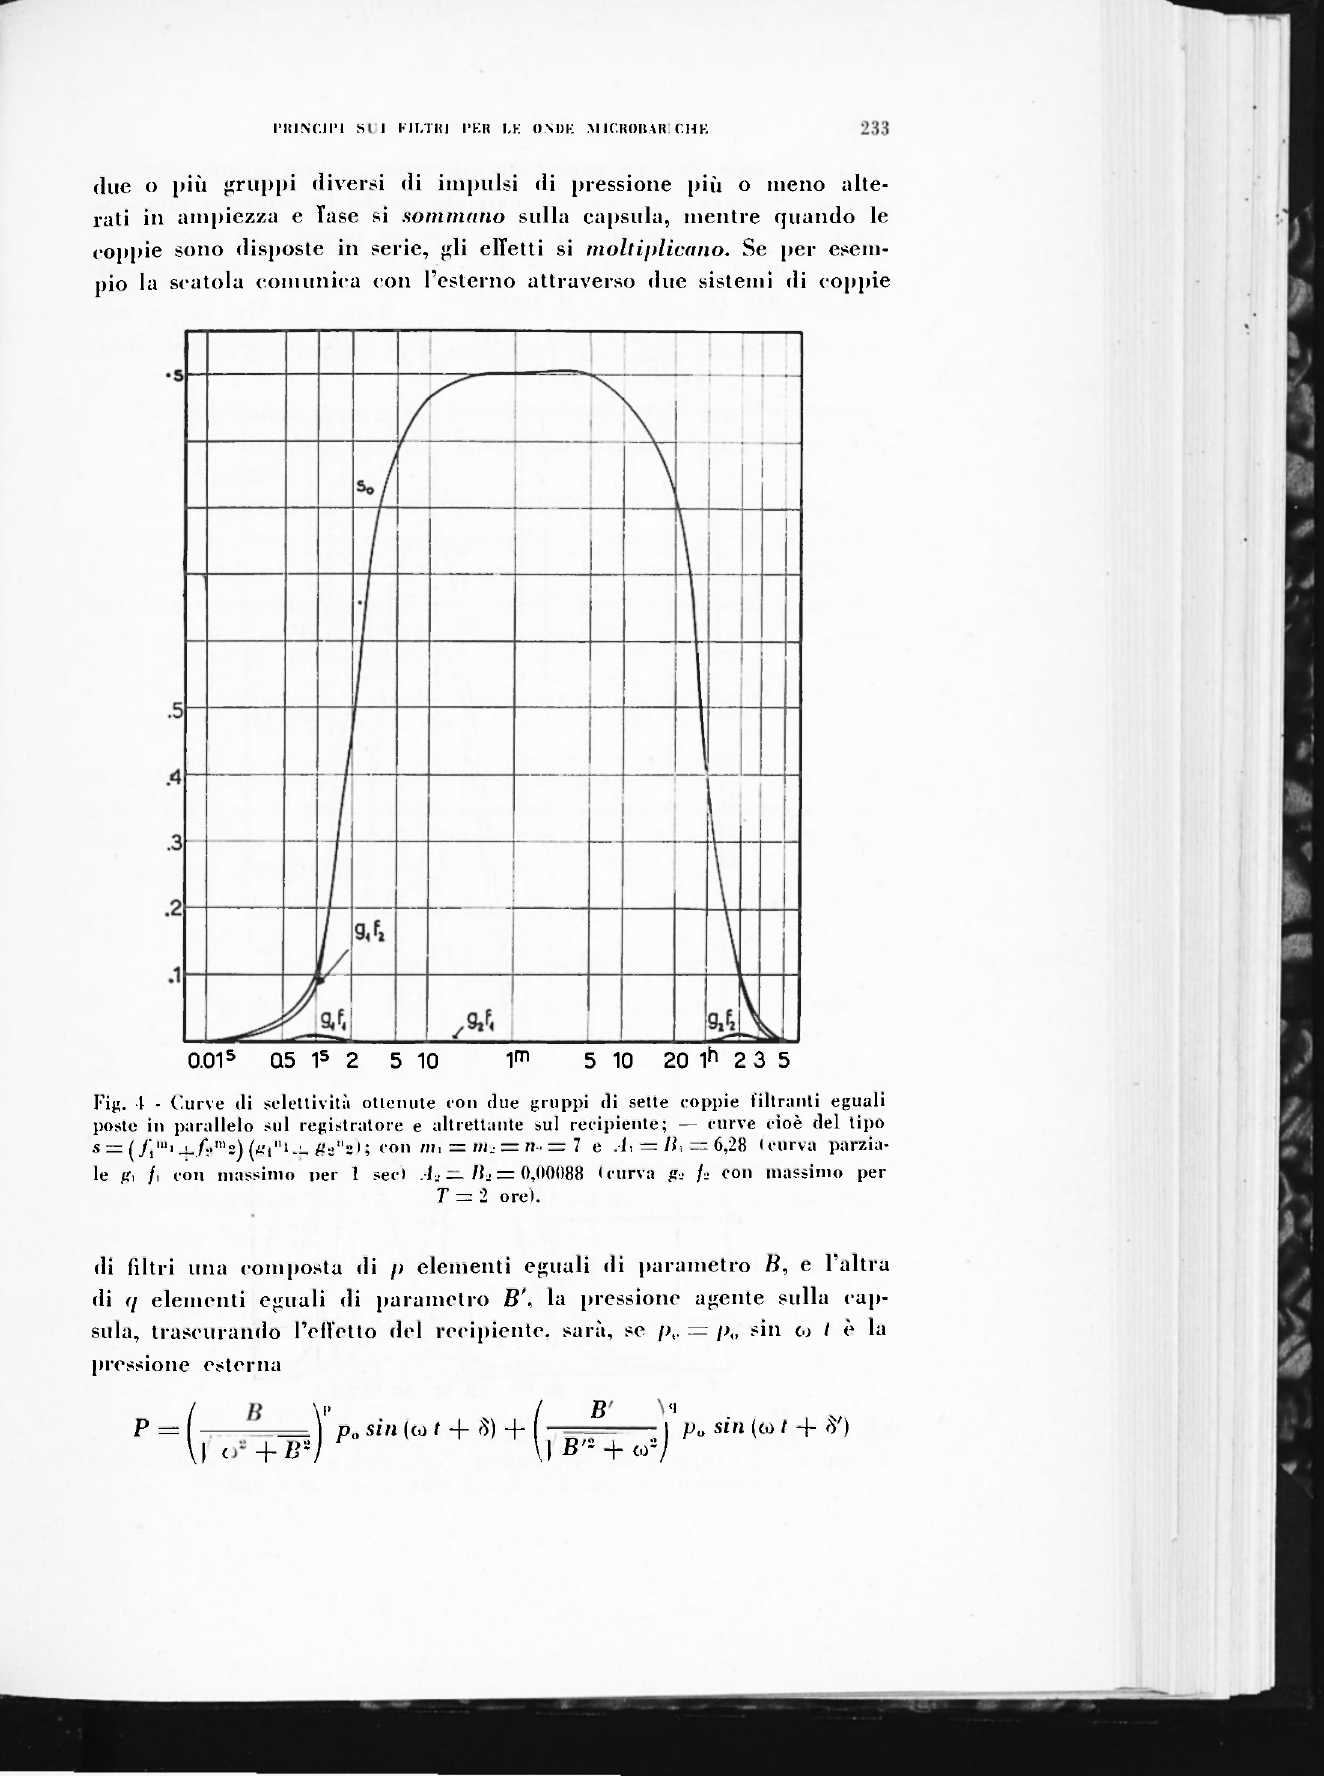
Fig. t - Curve ili selettività ottenute con due gruppi di sette coppie filtranti eguali poste in parallelo sul registratore e altrettante sul recipiente; — curve cioè del tipo s = (/,'"'-J-/» M 2) (gi"i-u g«"z); con ni, = HI.- = n» = 7 e A i = H, = 6,28 (curva parzia- le g, /, con massimo per 1 sec) Ai — Ih = 0,00088 (curva gì fi con massimo per T = 2